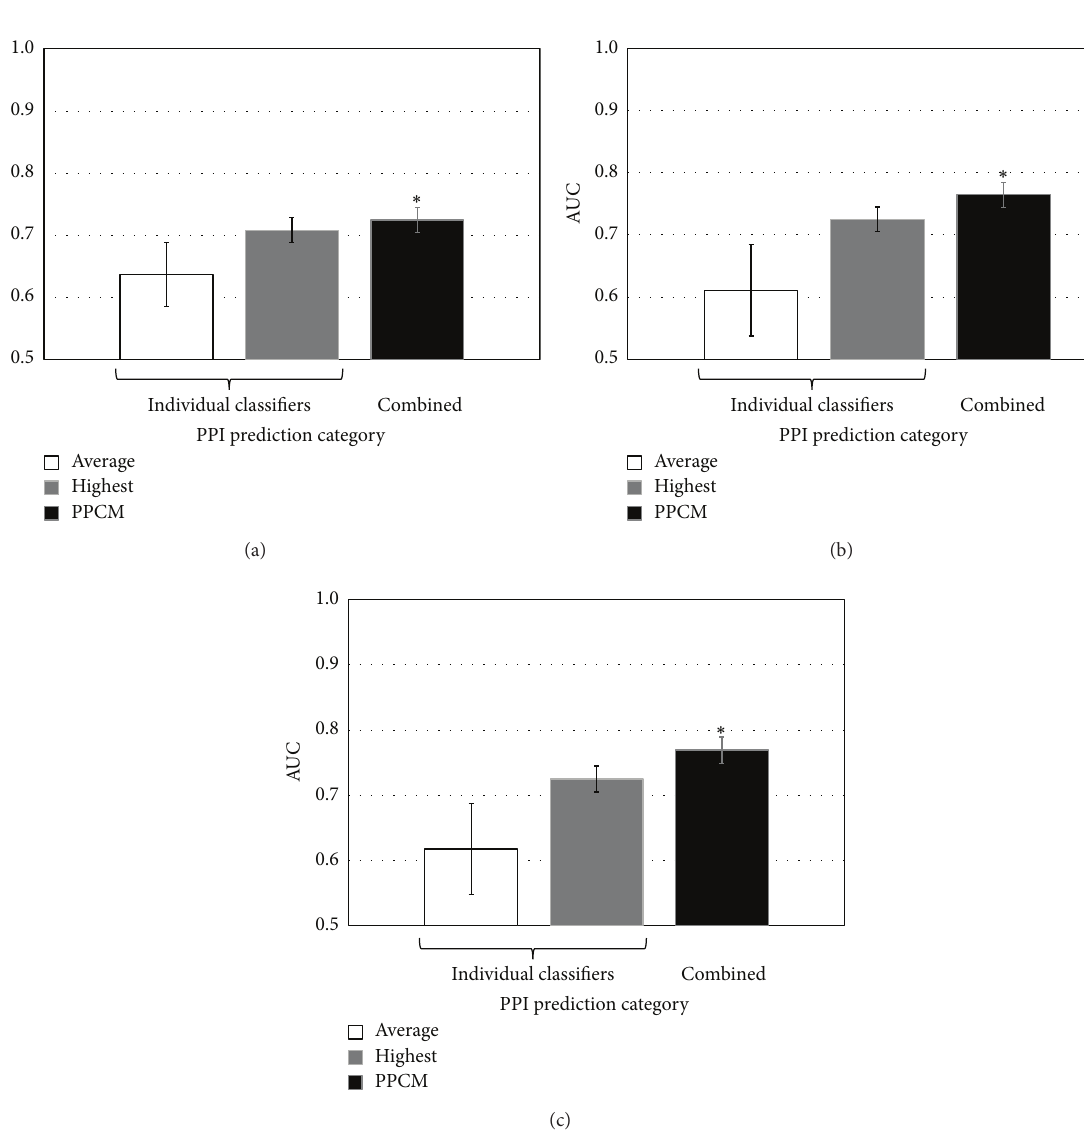
Figure 3: Comparison of PPI prediction accuracy in the Phyloprof category. (a) PPI prediction based on classifiers related to SC. (b) PPI prediction based on classifiers related to cross species. (c) PPI prediction based on classifiers related to all species. “Average” represents the mean AUC of all the classifiers in each category. “Highest” represents the classifier with highest AUC among all the classifiers in each category. Error bars show standard deviation. “ ∗ ” indicates that AUC of PPCM was significantly ( 𝑃 value < 0.05; 𝑡 -test) higher than that of the most accurate classifier in each